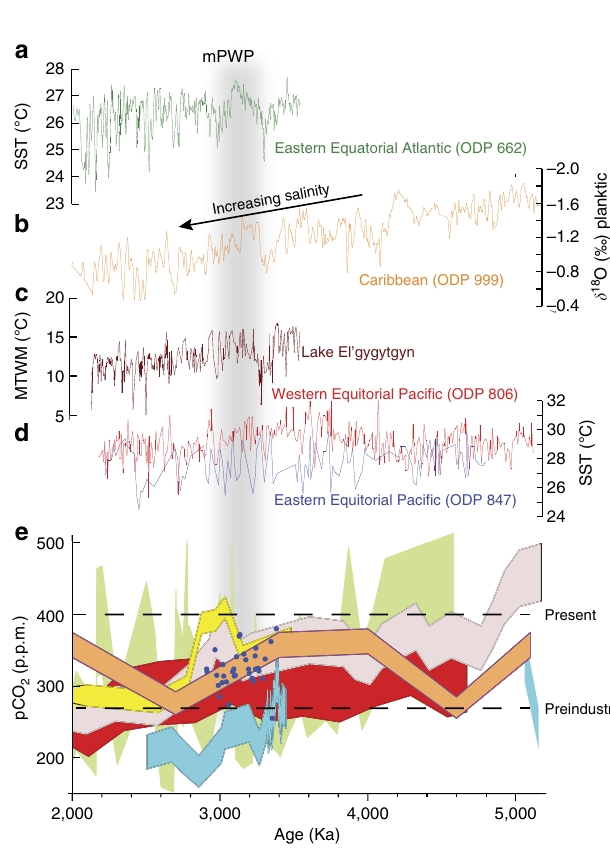
Figure 2 | Sample time series analyses. Time series illustrating commonly used palaeoenvironmental proxies. Vertical grey band represents position of mPWP. ( a ) Equatorial Atlantic SST based on alkenone unsaturation index 44 . ( b ) Caribbean Sea oxygen isotope record 111 showing increasing salinity due to shoaling of the Central American Seaway. ( c ) Terrestrial record of the mean warmest month temperature from Lake El’gygytgyn 56 . ( d ) Equatorial Pacific SSTrecords based on Mg/Ca palaeothermometry 51 . ( e ) Estimates of Pliocene atmospheric CO 2 with pre-industrial and present day levels (horizontal dashed lines) for comparison; dark blue dots, d 13 C (ref. 3); green band, d 11 B (ref. 7); pink band, alkenone 5 ; red band, alkenone 6 ; orange band, stomata 4 ; yellow band, d 11 B (ref. 5); blue band, Ba/Ca 59 ; Modified from ref.